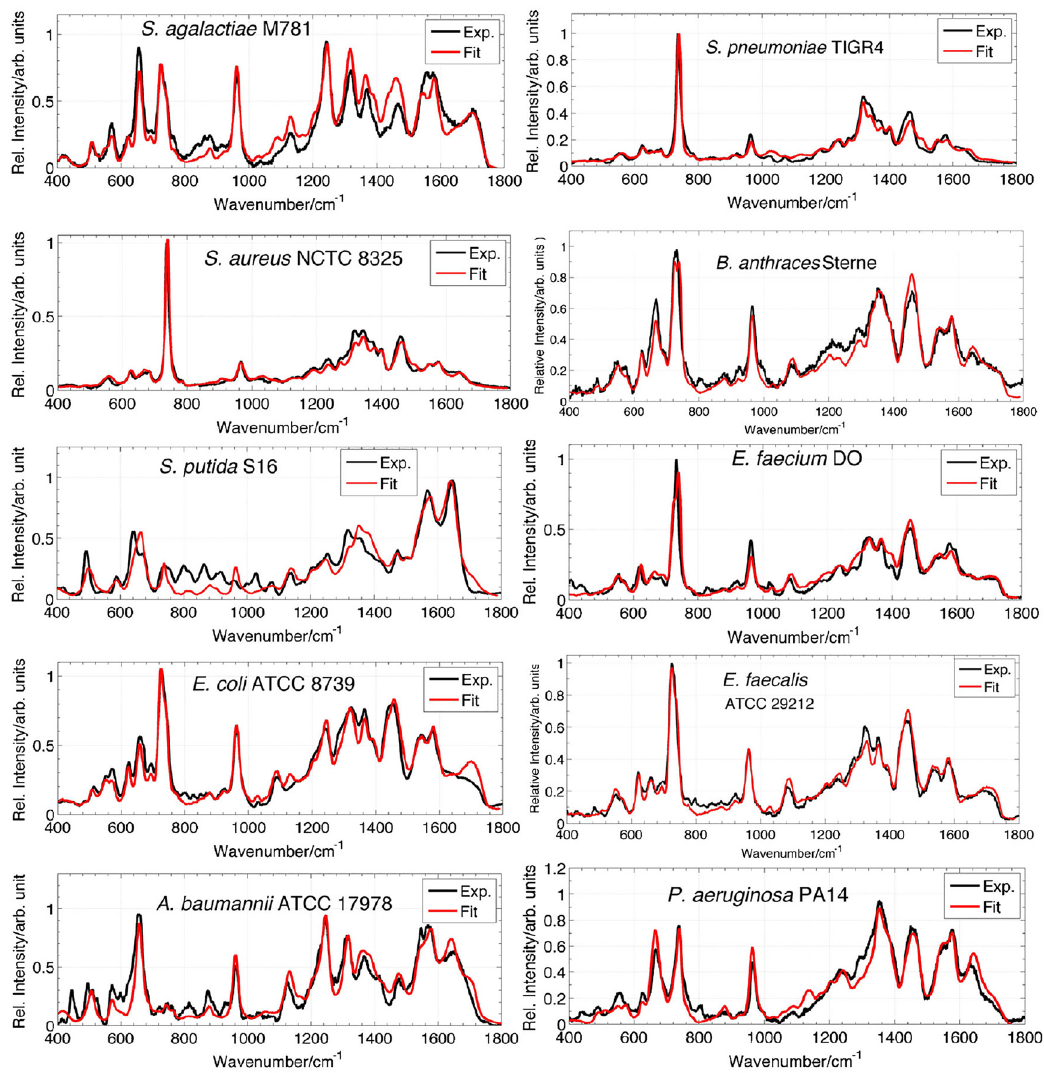
Figure 7: Empirically determined best fits (red) of the bacterial spectra (black) shown in Figure 5 to a linear combination of purine (adenine, hypoxanthine, xanthine, guanine, uric acid, and AMP) surface enhanced Raman scattering (SERS) spectra shown in Figure 6. Excellent fi ts are obtained for all bacterial SERS spectra. Reprinted with permission from Premasiri et al. [55]: Springer Nature, Copyright